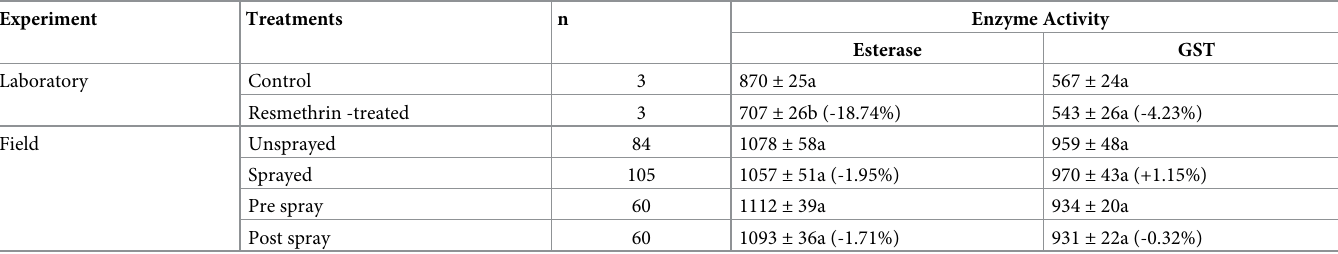
Table 3. Effect of insecticide exposure on enzyme activities in honey bees from laboratory and field studies.